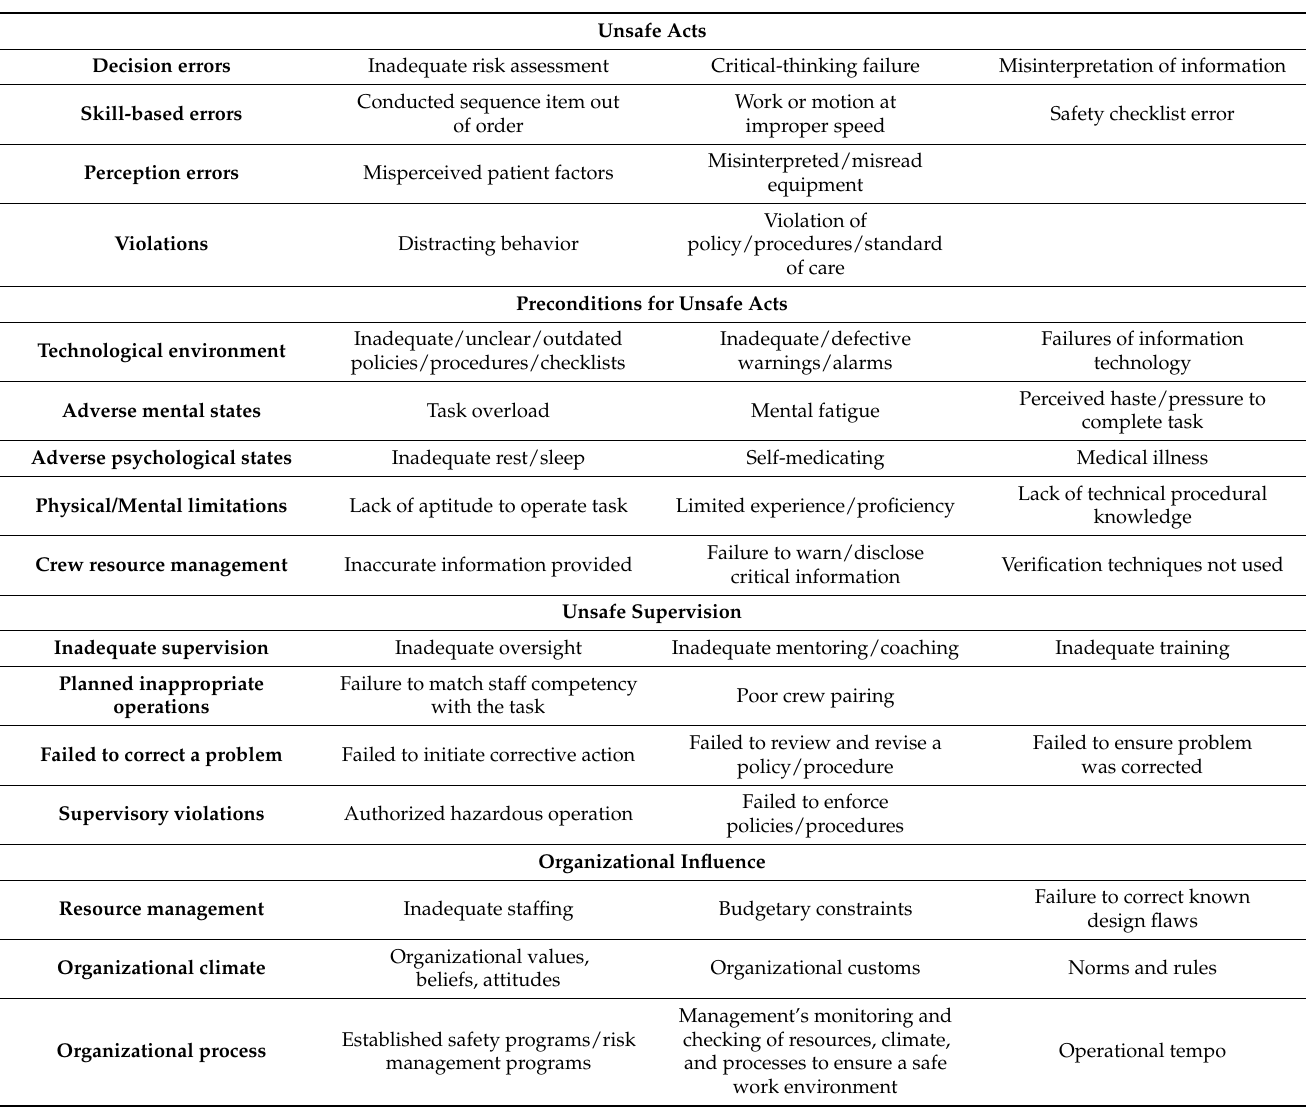
Table 7. Ranks of top three